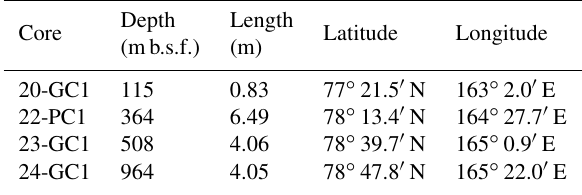
Figure 3. Detail of study area showing ship track with the yellow and orange lines indicating portions of the chirp sub-bottom data presented in Figs. 4 and 5. Locations of sediment cores discussed in the text are shown. Blue and brown shading represents the bounds of the glacial trough and trough mouth fan deposits (respectively) as interpreted from the geophysical data collected during SWERUS- C3-L2. Bathymetry from IBCAO (Jakobsson et al., 2012b), with 50m major contour intervals. Table 1. Location and length of sediment cores discussed in this